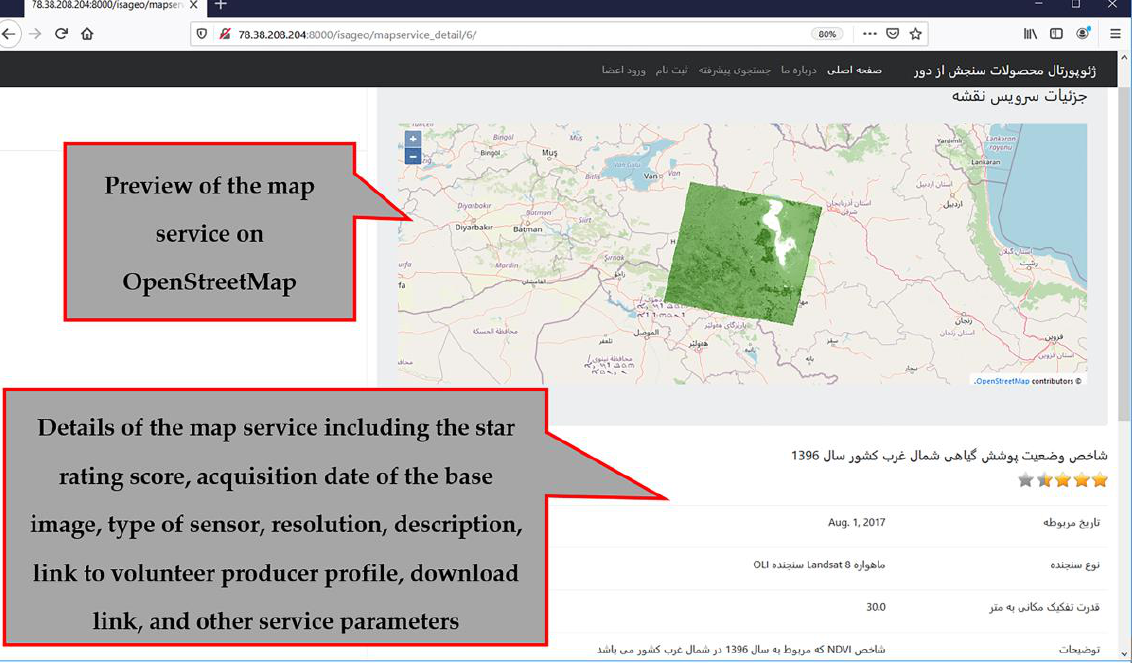
Figure 9. The details of map service including the preview, star score, metadata, download link, and service parameters.